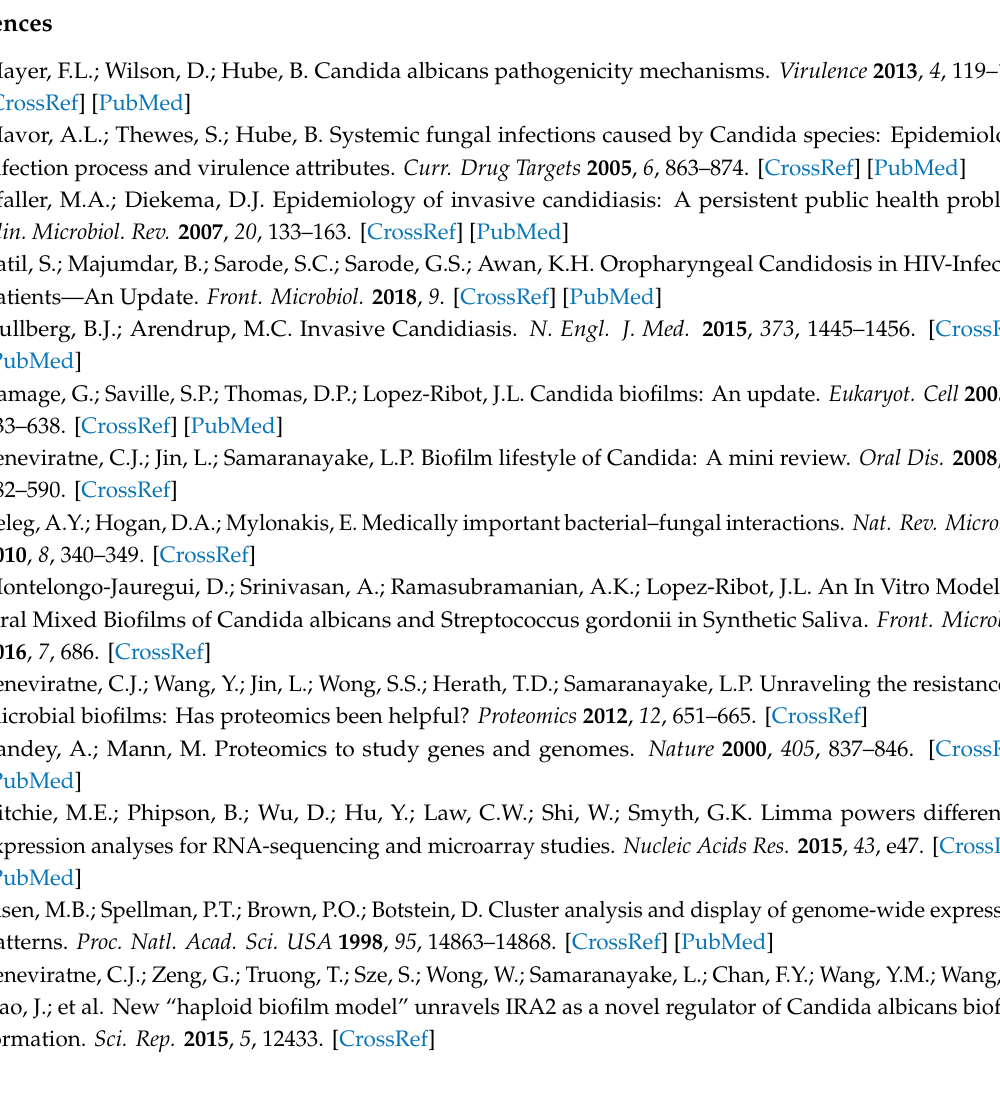
Table S1: List of proteins commonly expressed in C. albicans biofilms upon exposure to heat-killed bacteria, Table S2: Di ff erential expression analysis on proteomes of C. albicans biofilms revealed 35 significantly altered proteins when exposed to Gram-positive and Gram-negative heat-killed